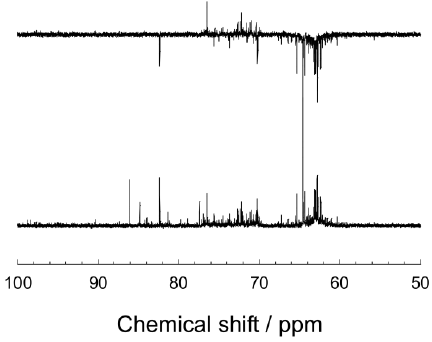
Figure 6. 13 C NMR ( lower ) and DEPT-135 spectra ( upper ) for the product of the formose reaction carried out using 1 M formaldehyde and 120 mM calcium hydroxide at 60 °C for 60 min in the presence of 5 g·L −1 pDMA/VBA. carried out using 1 M formaldehyde and 120 mM calcium hydroxide at 60 of 5 g · L − 1